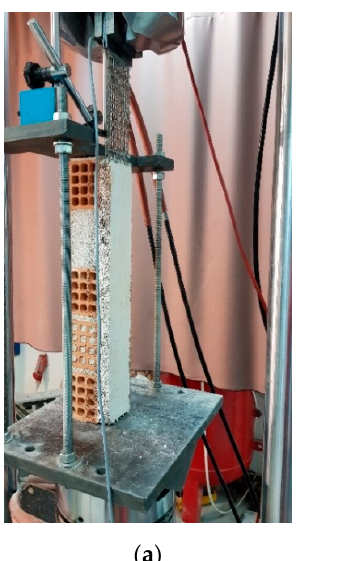
Figure 6. Shear testing: ( a ) bond–slip testing of the retrofiting system; ( b ) specimen geometry.